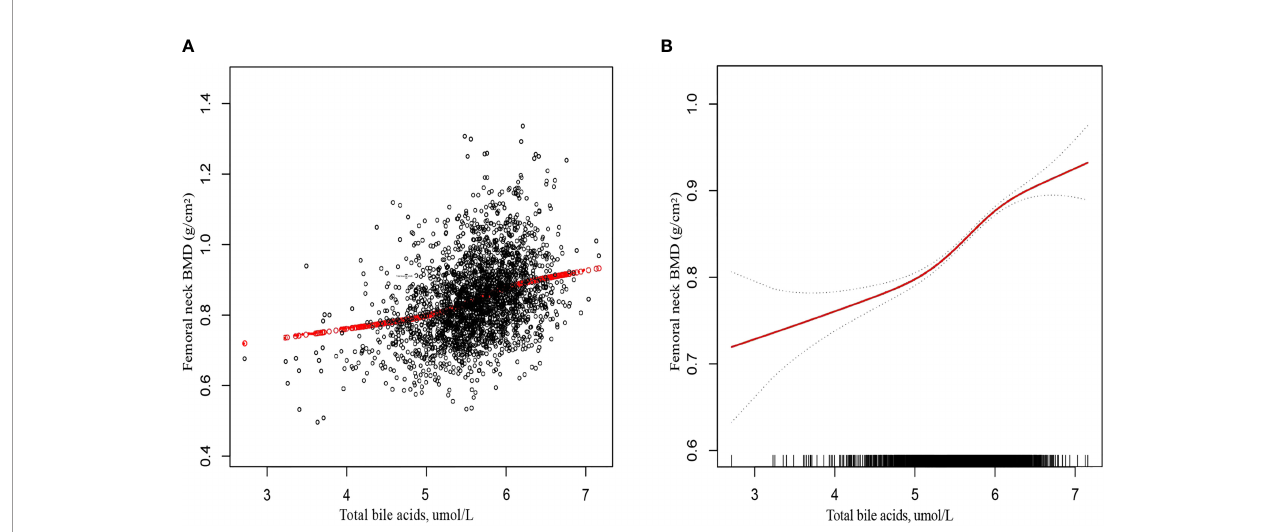
FIGURE 2 | The association between total bile acids and femoral neck bone mineral density. (A) Each black point represents a sample. (B) The solid red line represents the smooth curve fi t between variables. Gray bands represent the 95% con fi dence interval from the fi t. Age, sex, education, obesity, smoking status, CKD, diabetes, hypertension, drinking status, TBil, AST, ALP, GGT, ALT, TC, TG, HDL-C, and LDL-C were